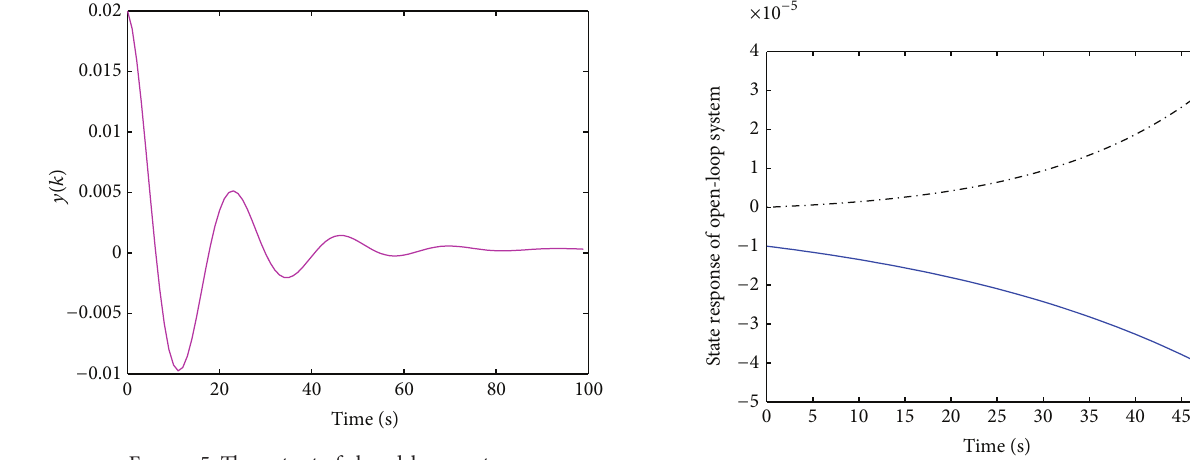
Figure 5: The output of closed-loop system.